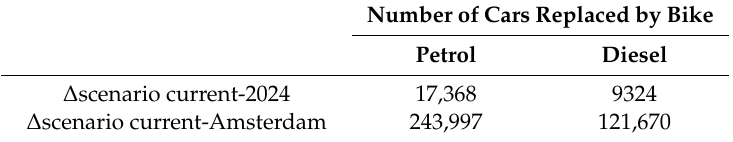
Table 5. Number of petrol and diesel car replaced by bike in the differest scenarios analysed. Number of Cars Replaced by Bike